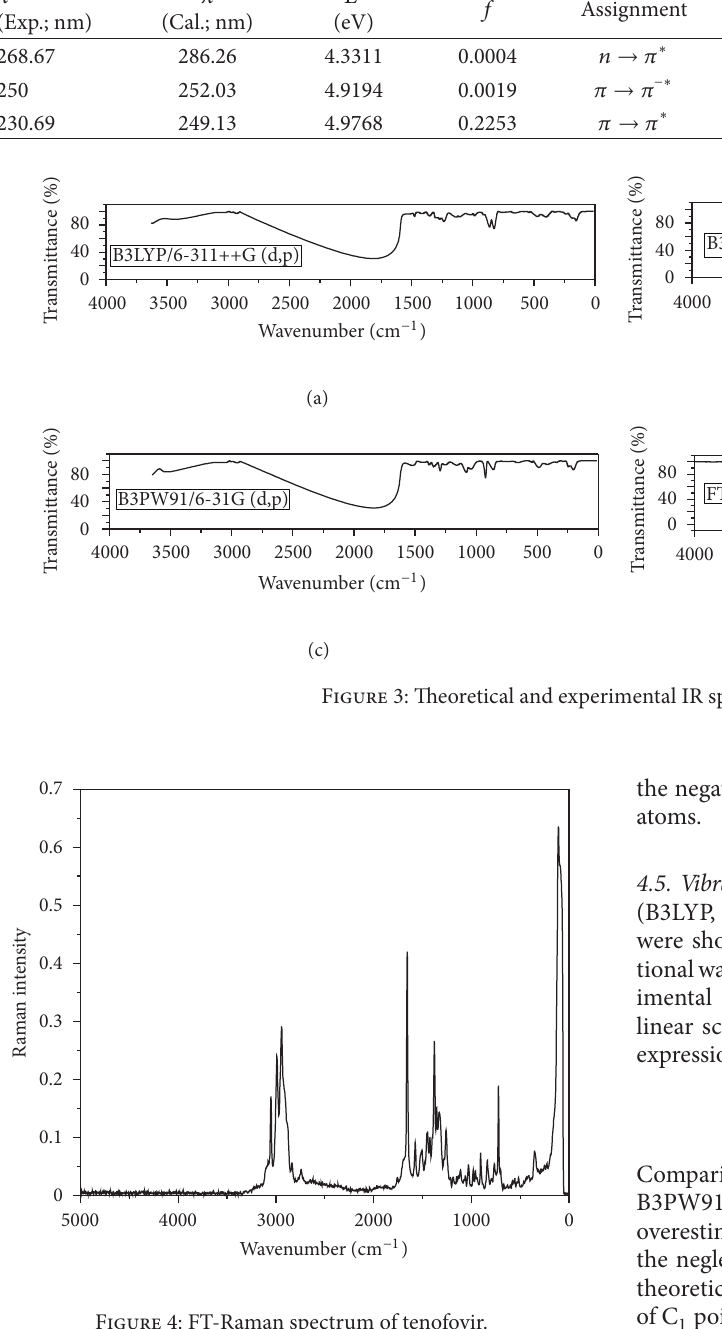
F 4: FT-Raman spectrum of